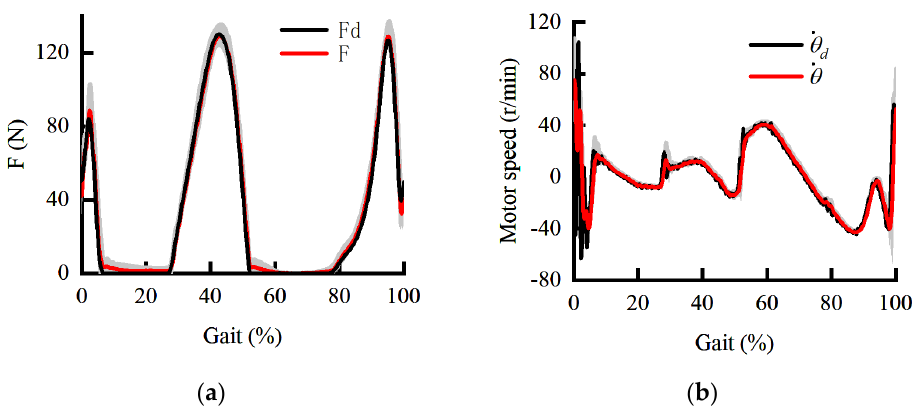
Figure 18. The dynamic curve under the HEIF-AO in the outer loop and the DOB in the inner loop during walking. ( a ) The dynamic curve of force response; ( b ) the dynamic curve of speed response.